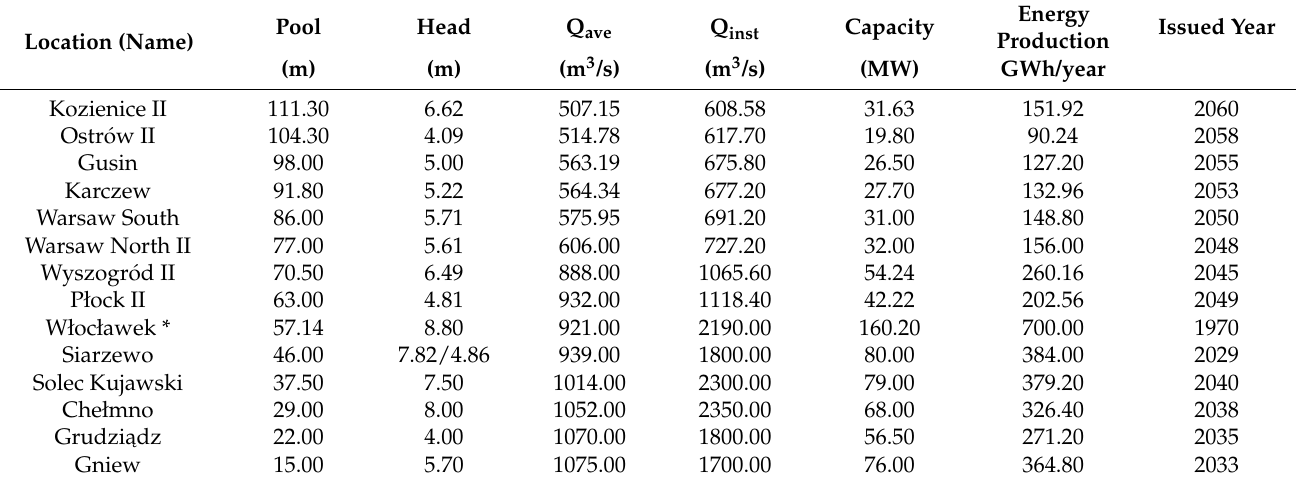
Table 1. Technical parameters of the proposed and existing dams on the Vistula River